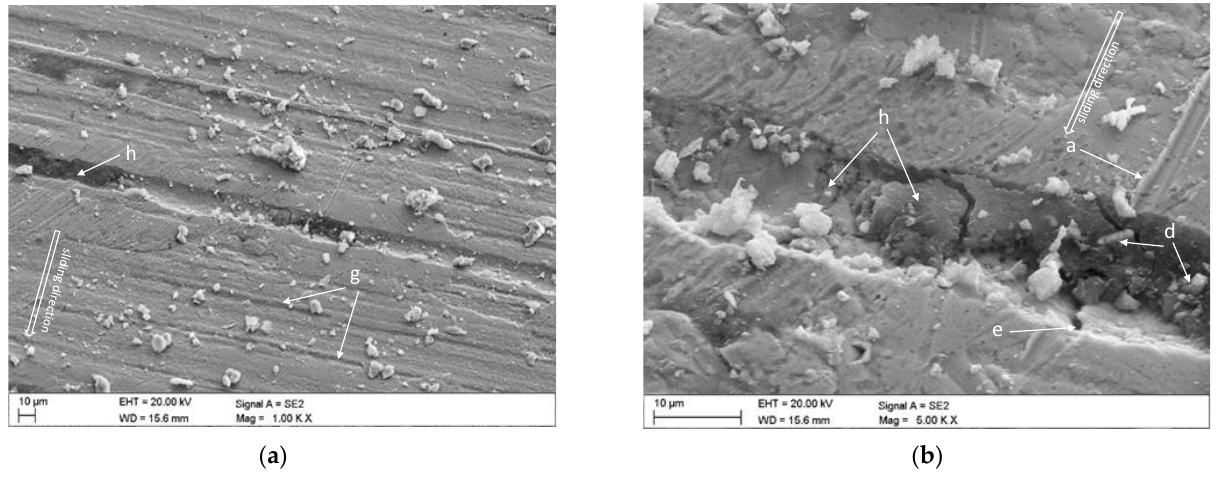
Figure 6. Sanding marks of WRS_400_I steel ( a ) filled with coal and crushed mineral grains ( b ) after testing in the presence of coal (SEM); symbols: a—grooves, d—debris, e—surface crack (exfoliation), g—sanding marks, h—coal-filled sanding marks.